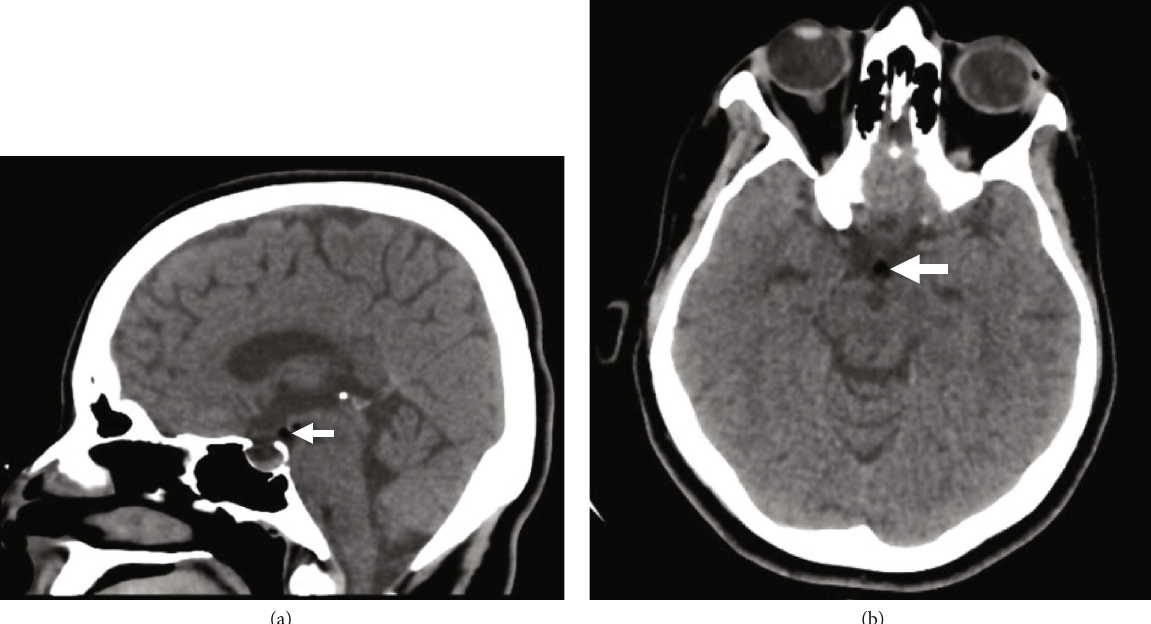
Figure 6: (a) Sagittal brain CT. (b) Axial brain CT. (a) and (b) A hypothalamic lipoma is noted measuring 4 × 4 × 4mm in maximal